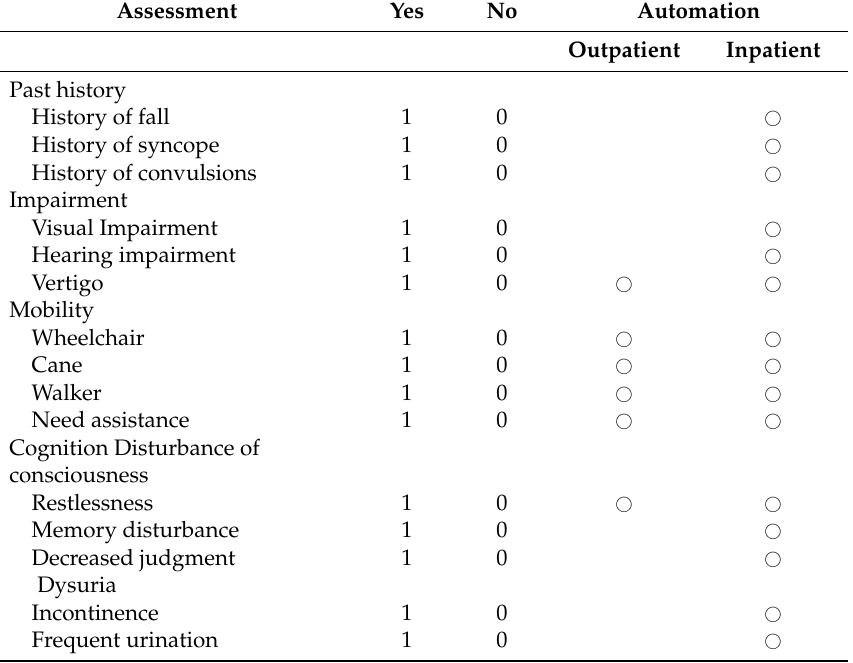
Table 1. Assessment score sheet for the patients and target of